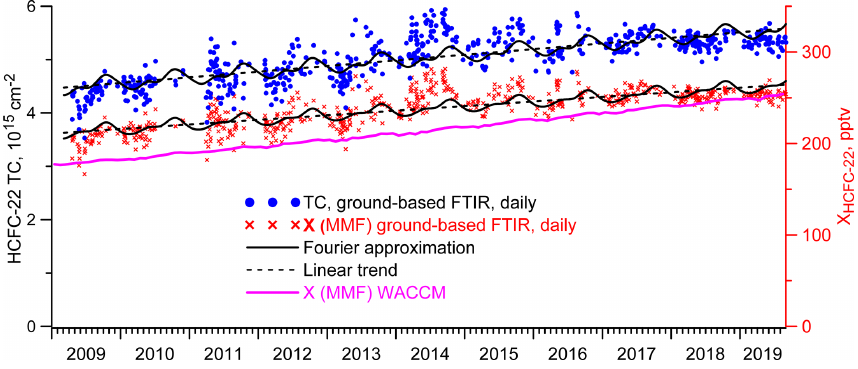
Figure 6. Daily mean TCs and Xgas of HCFC-22. Filtered results of the T − Ph parameter α = 3 × 10 3 .